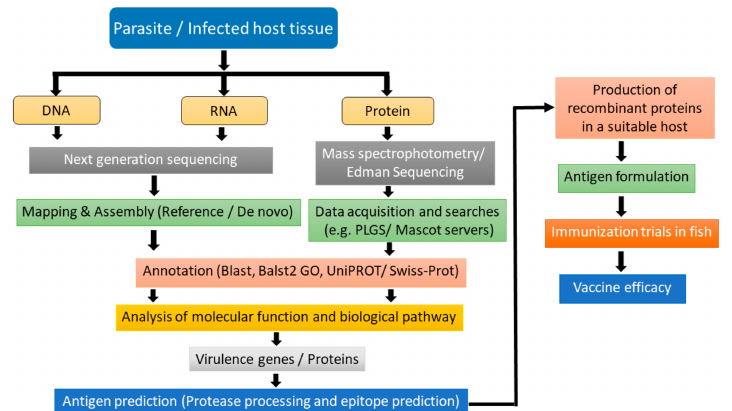
Figure 2. Workflow for identification of vaccine candidates and vaccine formulation using high throughput omics techniques. The material of interest (DNA, RNA or protein) can be extracted from the desired parasite or from-infected host fish tissue. The isolated material serves as sample for next generation sequence analysis (for DNA and RNA) and spectrophotometry and Edman sequencing (for protein). The obtained sequences can be subjected to different bioinformatic tools for analysis and functional annotation of parasite molecules. Based on molecular function and biological pathway analysis, the immunogenic targets (capable of eliciting host immune response) can be selected and their protective epitopes predicted. These molecules can then be produced on a large scale and combined with suitable adjuvants to form vaccine. Subsequently, the vaccine thus produced can be used for conducting trials in suitable fish and its efficacy and appropriate route of administration can be